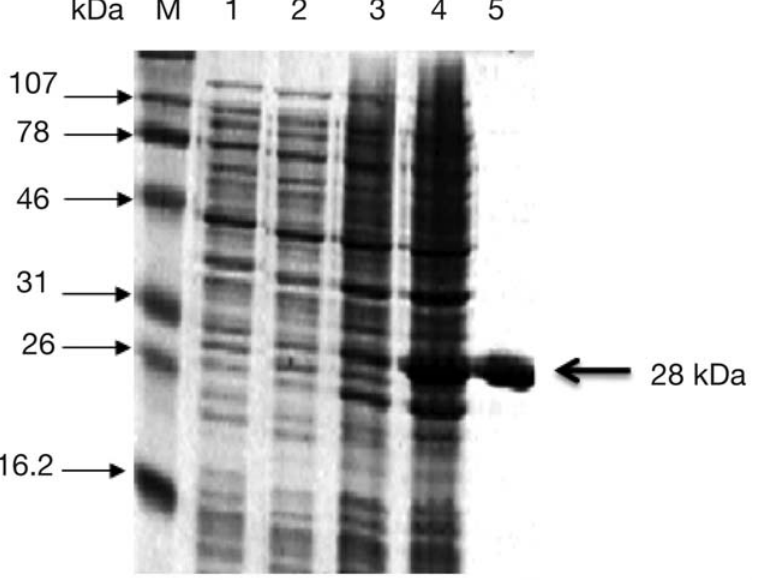
Figure 2. Expression and purification of rWbGST. Cultures of E. coli containing pRSETA and rWbGST expression construct were induced with 1 mM IPTG. Following induction, rWbGST was purified from the cultures using a cobalt metal affinity chromatography column. Approximately 1 m g of the purified protein was then separated in a 15% SDS-PAGE and stained with coomassie brilliant blue R250. Lane 1- pRSET-A uninduced, Lane 2- pRSET-A induced, Lane 3- rWbGST uninduced, Lane 4- rWbGST induced, Lane 5- Purified rWbGST and Lane M is protein molecular weight marker.